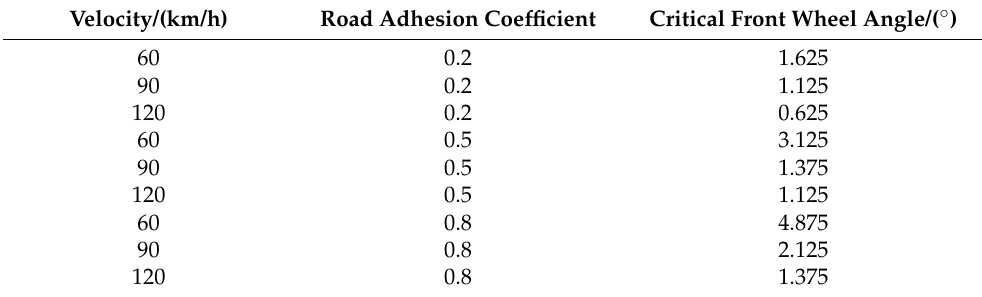
Table 2. Table of critical steering angles of different velocities and road adhesion coefficients.